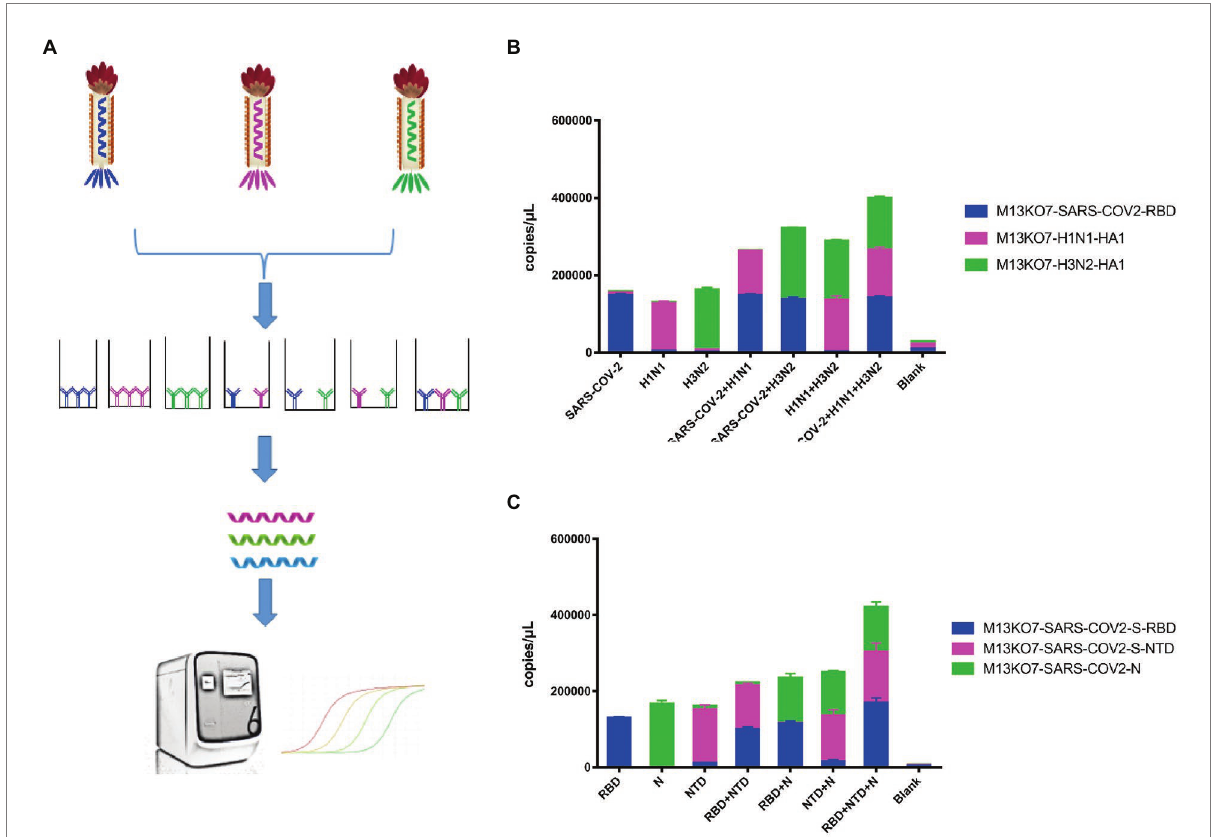
FIGURE 4 Pi-mqPCR was used to identify the binding specificity of recombinant phage. (A) Schematic drawing of the Pi-mqPCR. (B,C) Distribution of the phage chromosome that displayed antigens from different viruses (B) and different regions of SARS-CoV-2 (C) following immunoprecipitation with the respective labeled antibodies. The values shown are the average of three independent experiments and their standard